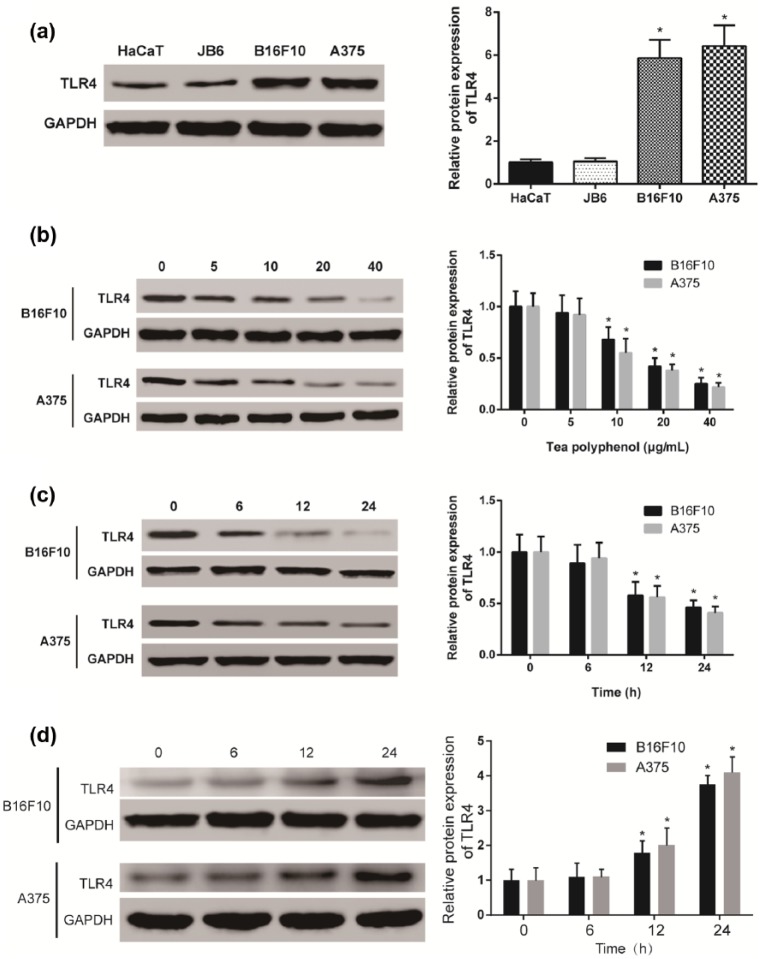
TP suppressed TLR4 expression in melanoma cells: (a) TLR4 was high
expressed in melanoma cell lines B16F10 (mouse) and A375 (human)
compared with normal skin cell lines HaCaT (human) and JB6 (mouse). (b)
TP decreased protein expression of TLR4 significantly and displayed
dosage dependence. Higher TP concentration resulted in lower TLR4
expression in B16F10 and A375 cell lines (*significant difference
compared with non-TP group with P <
0.05). (c) TP decreased protein expression of TLR4 significantly and
displayed time dependence. Longer treatment of 20 μg/ml TP led to less
TLR4 expression in B16F10 and A375 cell lines (*significant difference
compared with 0 h with P < 0.05), and
(d) removal of TP increased TLR4 protein expression and displayed time
dependence. Longer recovery led to higher TLR4 protein expression
(*significant difference compared with 0 h with P < 0.05).